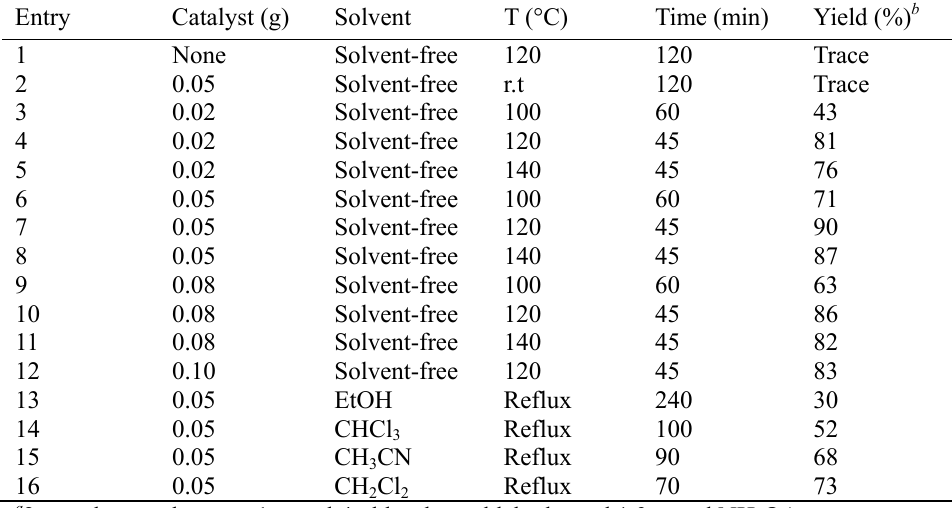
amount, solvent and temparature on the model reaction a Table 1. Effect of PPA-SiO 2